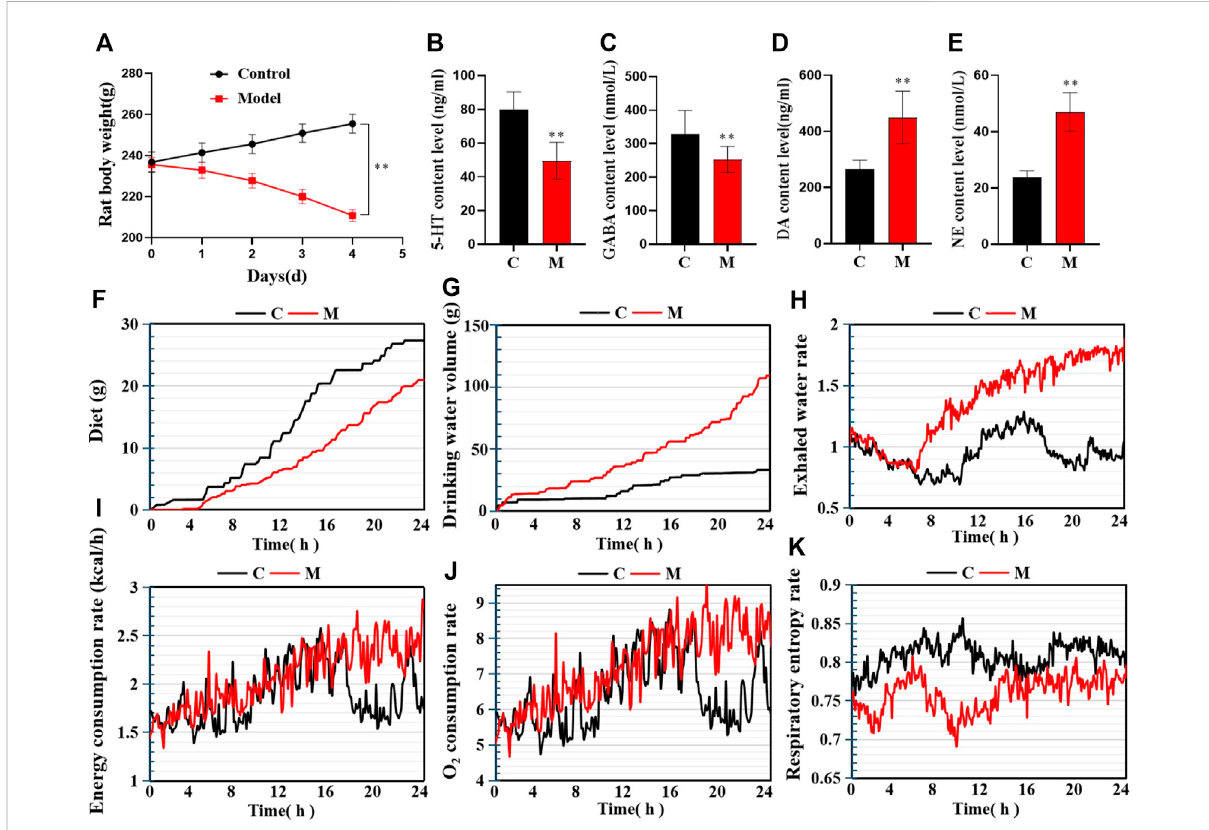
FIGURE 2 Model evaluation (C, control group, n = 10; M, model group, n = 10; compared with the C group, * p < 0.05, ** p < 0.01, mean ± SD). (A) Body weight changes during model establishment; (B) 5-HT content; (C) GABA content; (D) NE content; (E) DA content; (F) Food intake; (G) Water consumption; (H) Water exhalation rate; (I) Energy consumption; (J) Oxygen consumption; (K) Respiratory